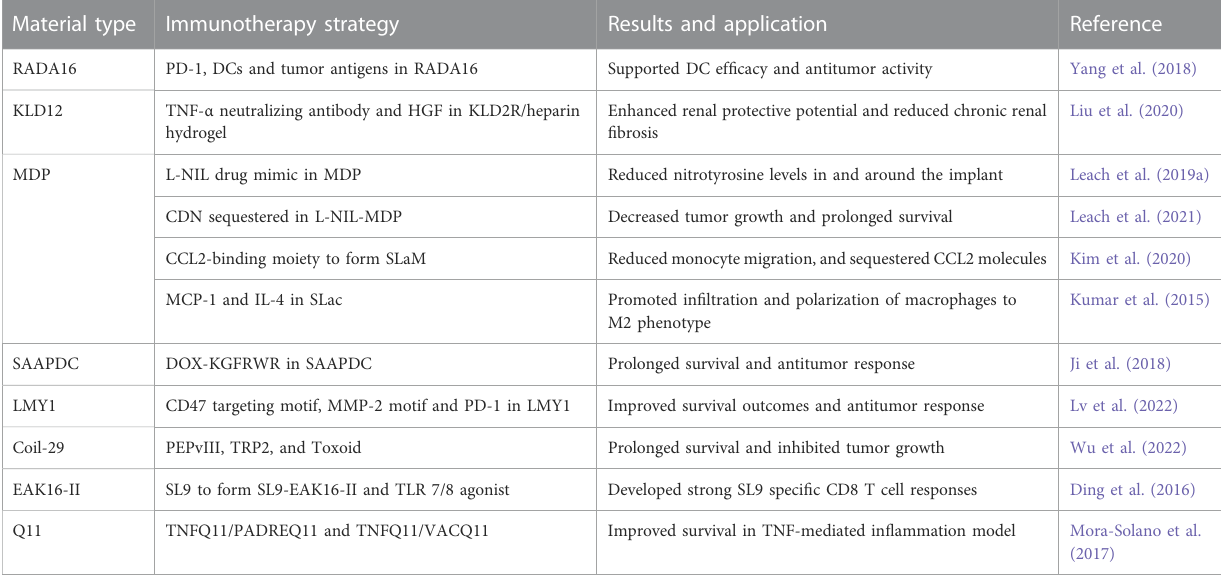
TABLE 1 Overview of reviewed self-assembling peptide immunotherapy